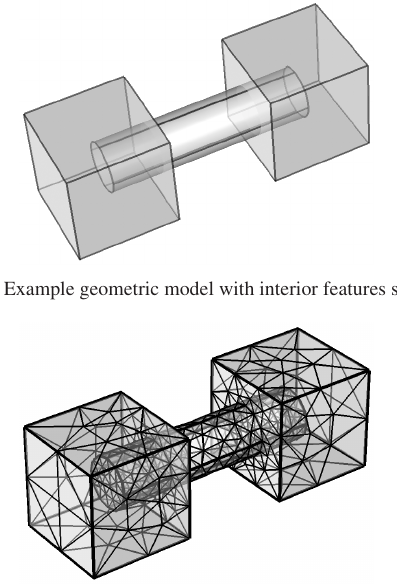
Fig. 5: Mesh representation of example geometric model. Coarse